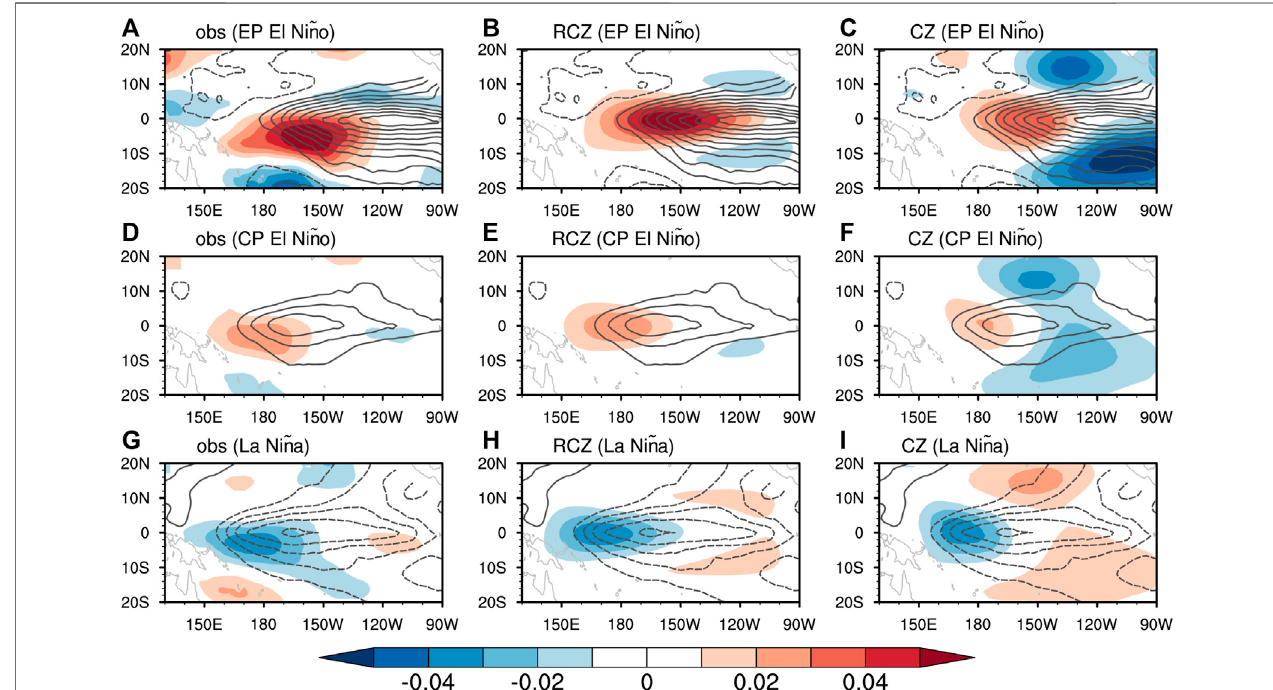
FIGURE 6 | Composited November-December-January (NDJ) average zonal wind stress anomalies (shading; unit: N/m 2 ) associated with EP El Niño, CP El Niño, and La Niña in (A,D,G) the observations, (B,E,H) the RCZ atmospheric component simulation, and (C,F,I) the CZ model atmospheric component simulation. Contours ineachplotdenotethecorrespondingobservedSSTA.Thecontourlevelis0.4 ° C,anddashedcontoursrepresentcoldSSTA.EPElNiño(1982,1997)/CPElNiño(1990, 1991, 1994, 2002, 2004, 2009) years are selected as the monthly E-index/C-index (Takahashi et al., 2011) exceeds one standard deviation from October to February. La Niña years (1988, 1998, 1999, 2007, 2010) are similarly selected as Niño 3.4 index is smaller than minus-one standard deviation.